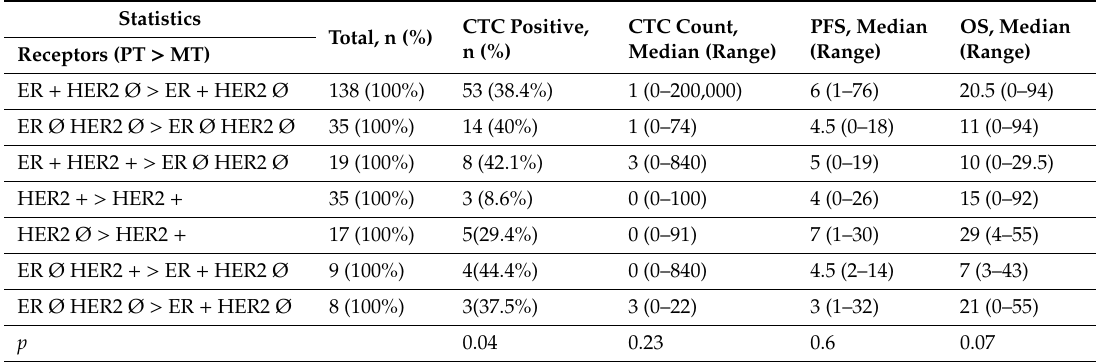
Table 2. Comparing CTC status, CTC count, and PFS and OS between subgroups defined by specific patterns of tumor subtype conversion.